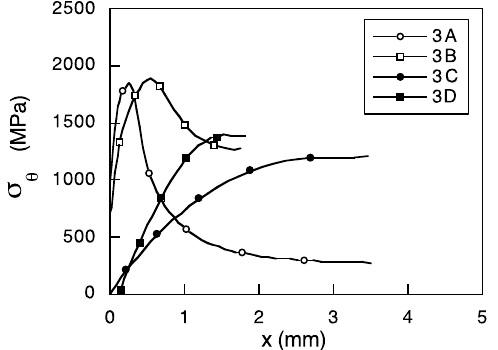
Figure 11. Distribution of hoop stress in notched samples of steel A3.